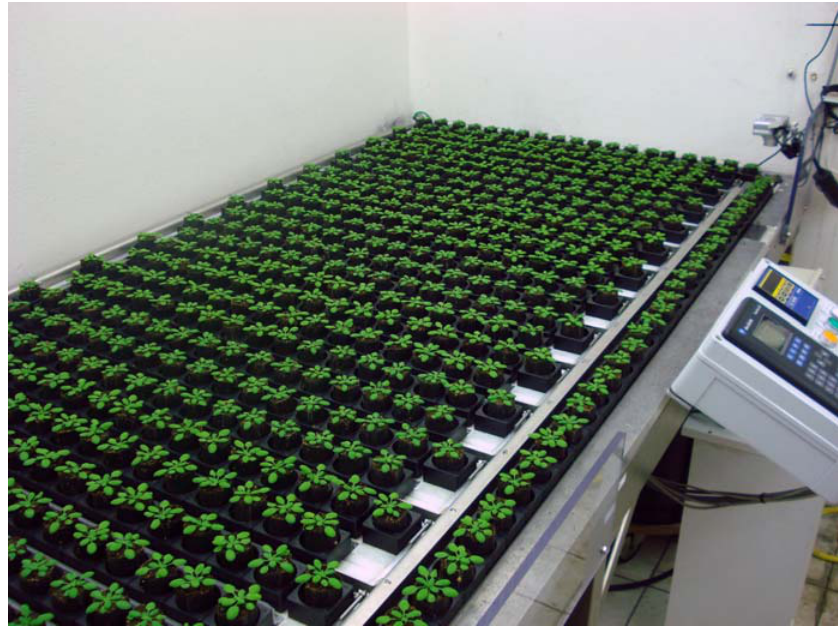
Figure 2. Phenoscope: this Arabidopsis culture system created at INRA-IJPB Versailles is able to grow and move 735 plants over the culture table, to adjust their water and nutrient status individually and to monitor their growth by image